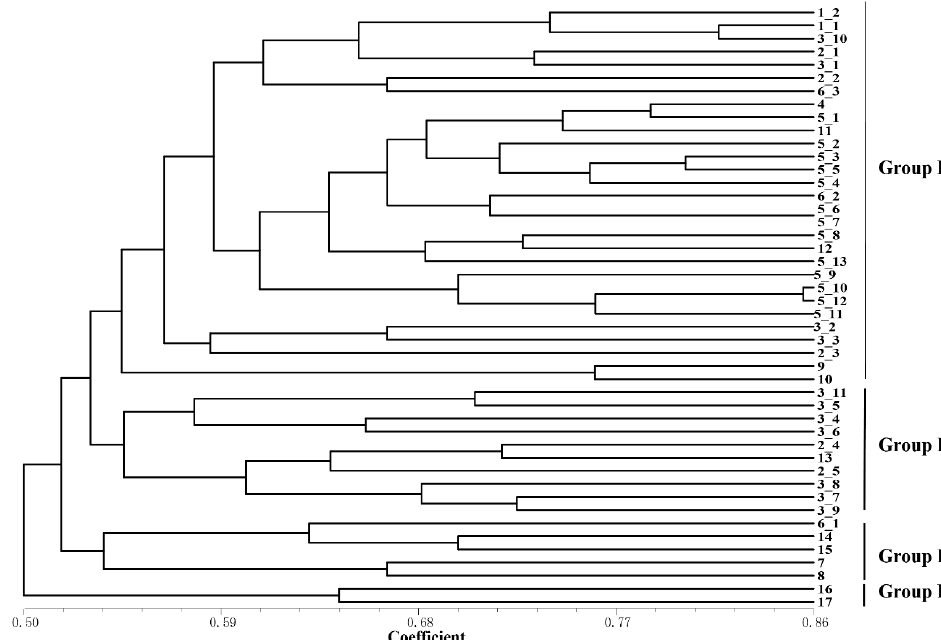
Figure 5. The genetic relationship dendrogram of ISSR amplification from 46 rhododendron acces- sions constructed using the UPGMA method based on the Jaccard similarity coefficient. To assess the robustness of each node, a bootstrap with 1000 replicates was performed on the loci data.